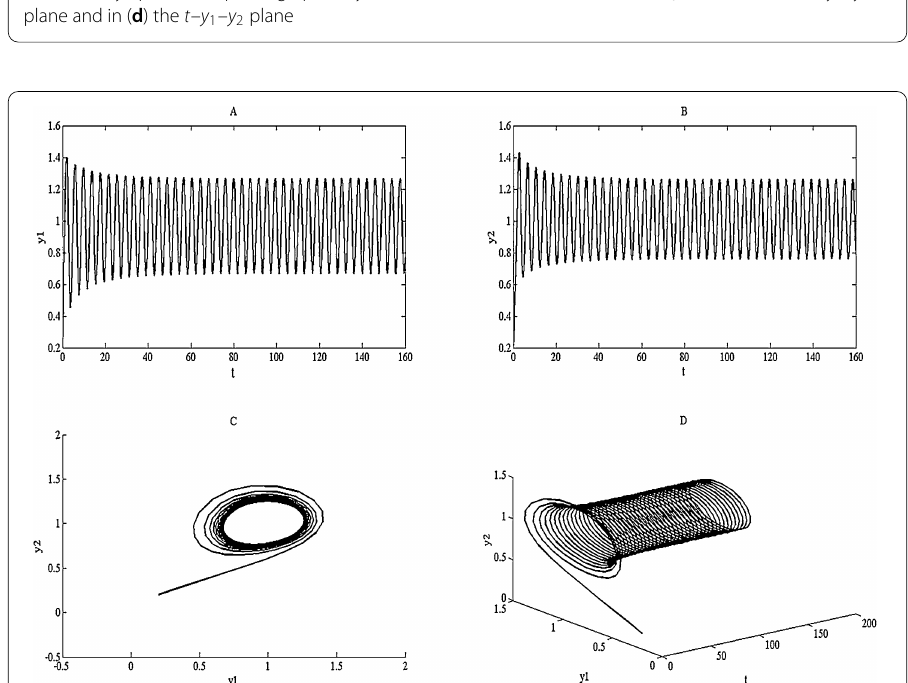
Figure 2 The trajectory graph of system (3.1) with τ 1 = 0.6, τ 2 = 0.6/3, τ 3 = 1.2/3 in ( a ) the t – y 1 plane and in ( b ) the t – y 2 plane. The phase graph of system (3.1) with τ 1 = 0.6, τ 2 = 0.6/3, τ 3 = 1.2/3 in ( c ) the y 1 – y 2 plane and in ( d ) the t – y 1 – y 2